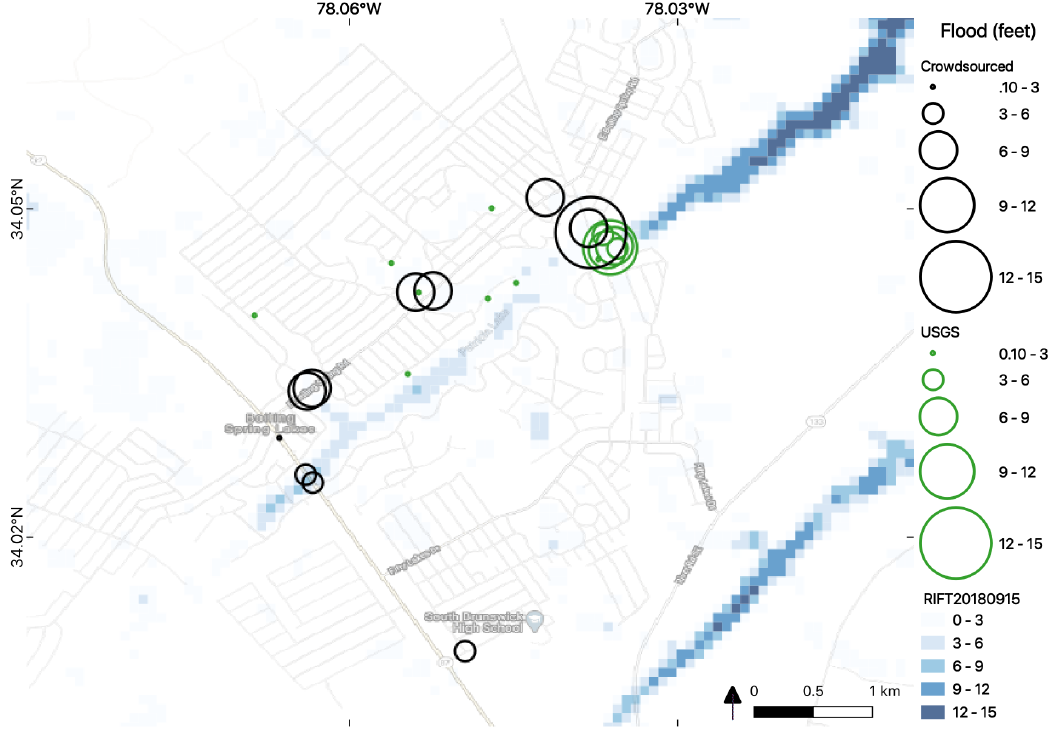
Figure 11. Comparison of flood depth in Boiling Spring Lakes,